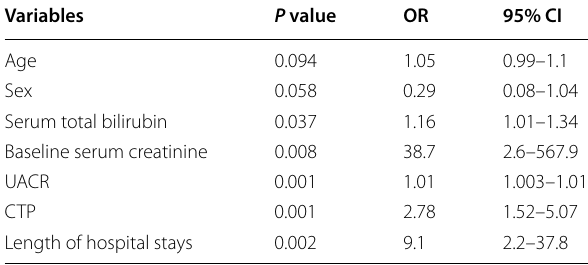
Table 4 Multi‑variate logistic regression analysis for factors predictive of HE‑AKI